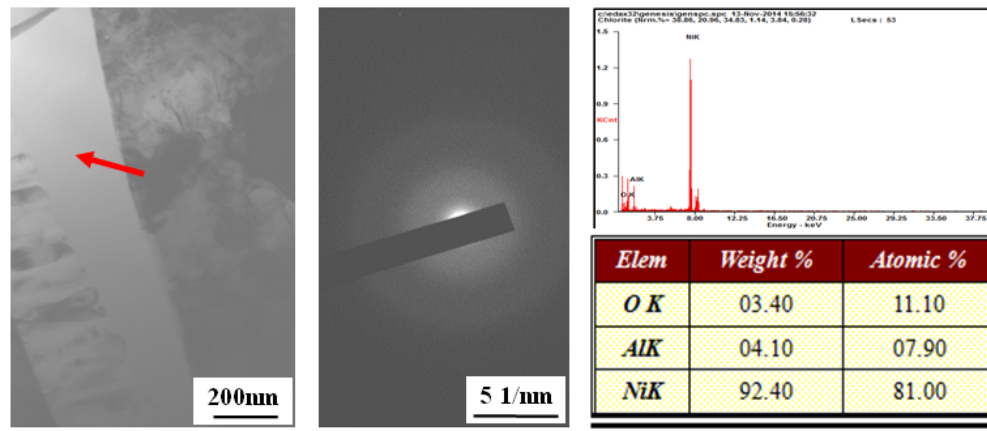
Figure 12. TEM morphology and electron microanalysis of the Ni-Al coatings for (a), (b) and